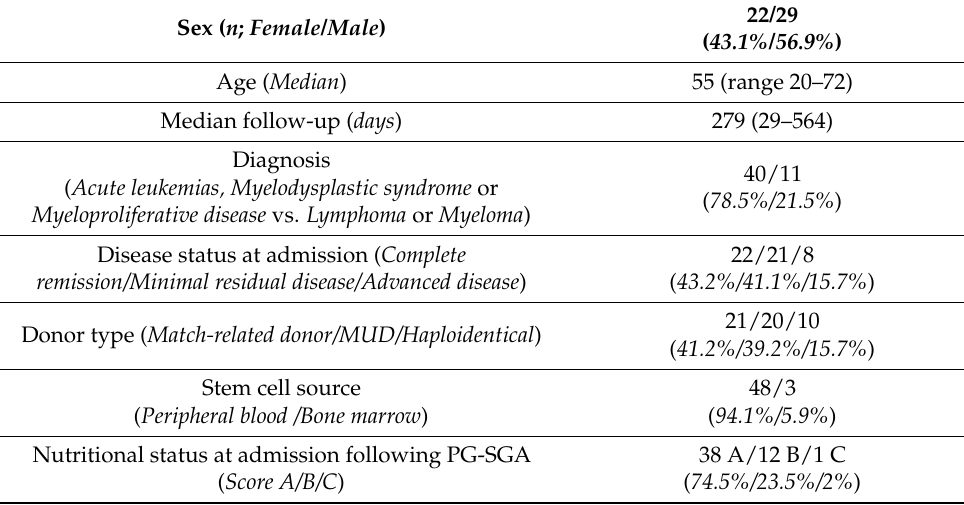
Table 1. Patients’ characteristics.